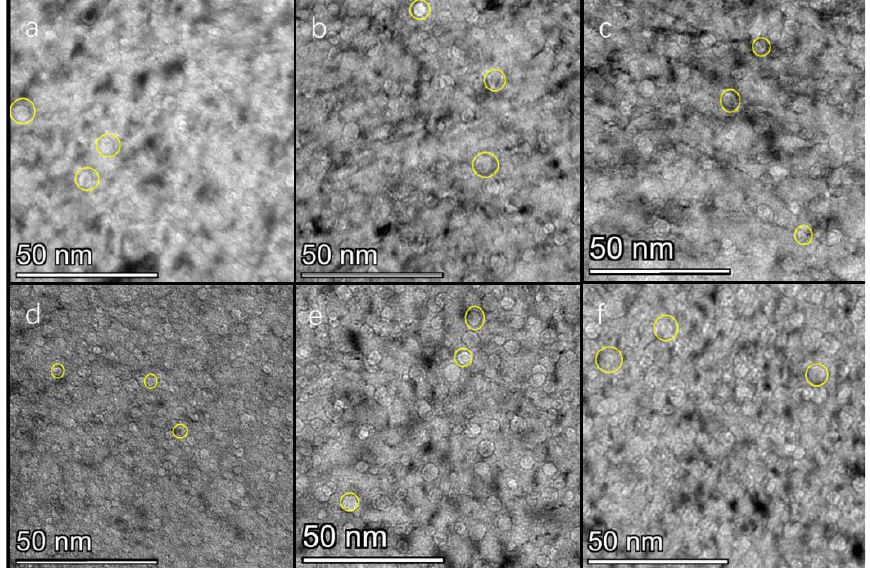
Figure 1. Cross-sectional TEM micrograph of He ion-implanted into single crystal Si (100 keV, dose 5 × 10 16 ions/cm 2 ) at different sample temperatures ( a ) 115 ◦ C, ( b ) 145 ◦ C, ( c ) 160 ◦ C, ( d ) 175 ◦ C, ( e ) 190 ◦ C, and ( f ) 220 ◦ C.